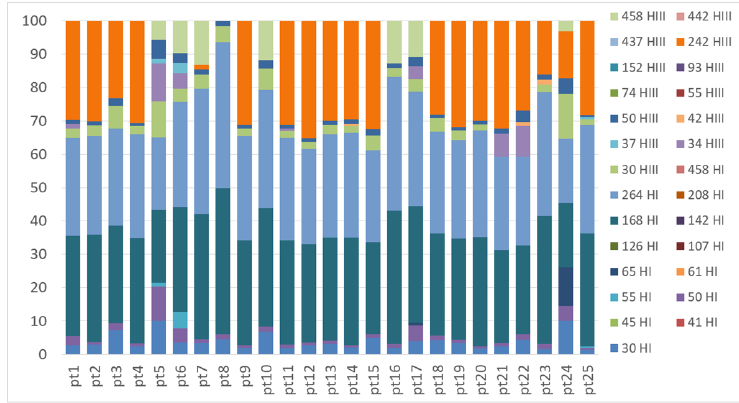
Figure A3. TRFLP profiles of the nif H gene obtained from Peltigera thallus samples with the restriction enzymes HhaI (TRFs indicated in the legend with a number followed by HI) and HaeIII (TRFs indicated in the legend with a number followed by HIII).